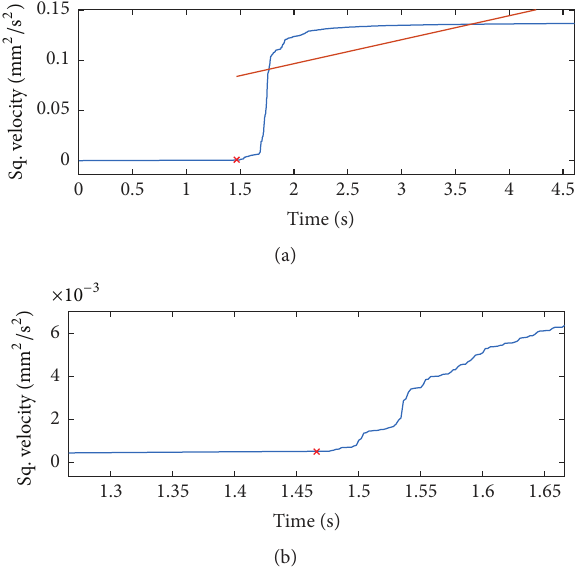
Figure 2: 𝐶 𝑥 󸀠 (𝑡) statistic applied to exemplary seismic signal presented in Figure 1 ( a ) and its zoom (b).